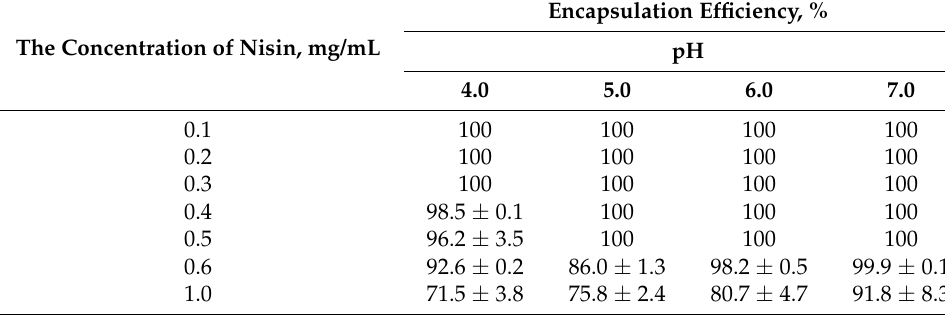
Table 1. The efficiency of nisin loading on particles obtained by the complexation 1 .